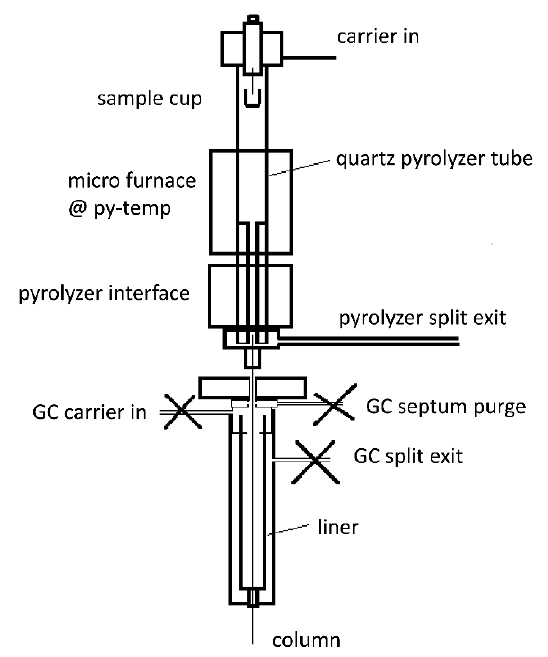
Figure 2. Septum-less connection of the pyrolyzer to the GC column, as developed at the RCE la- boratory.